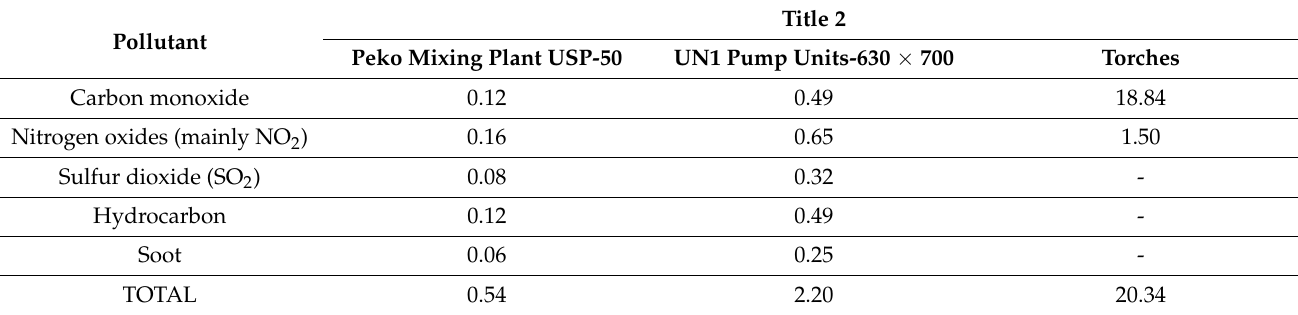
Table 3. Relation between the different contaminators and their emission